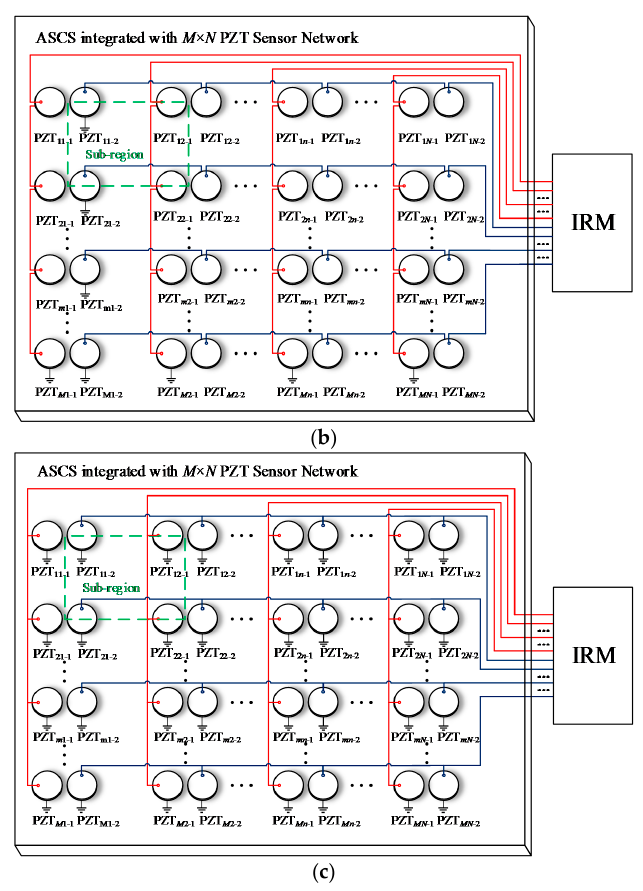
Figure 11. The architecture of: ( a ) Normal PZT sensor network; ( b ) CSSN; ( c ) CPSN.